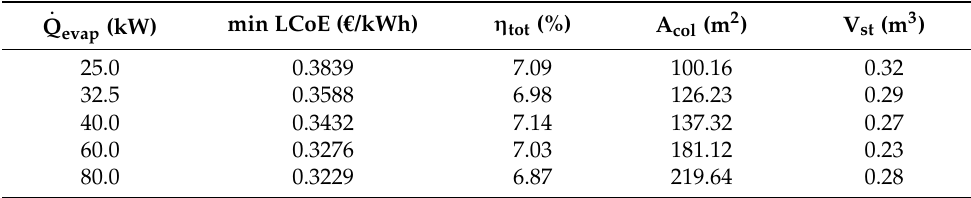
Table 12. Variation of the minimum levelized cost of electricity, corresponding total solar conversion efficiency and optimal solar field area and storage tank volume for different nominal system heat input values (Athens, PTC, Cyclopentane).